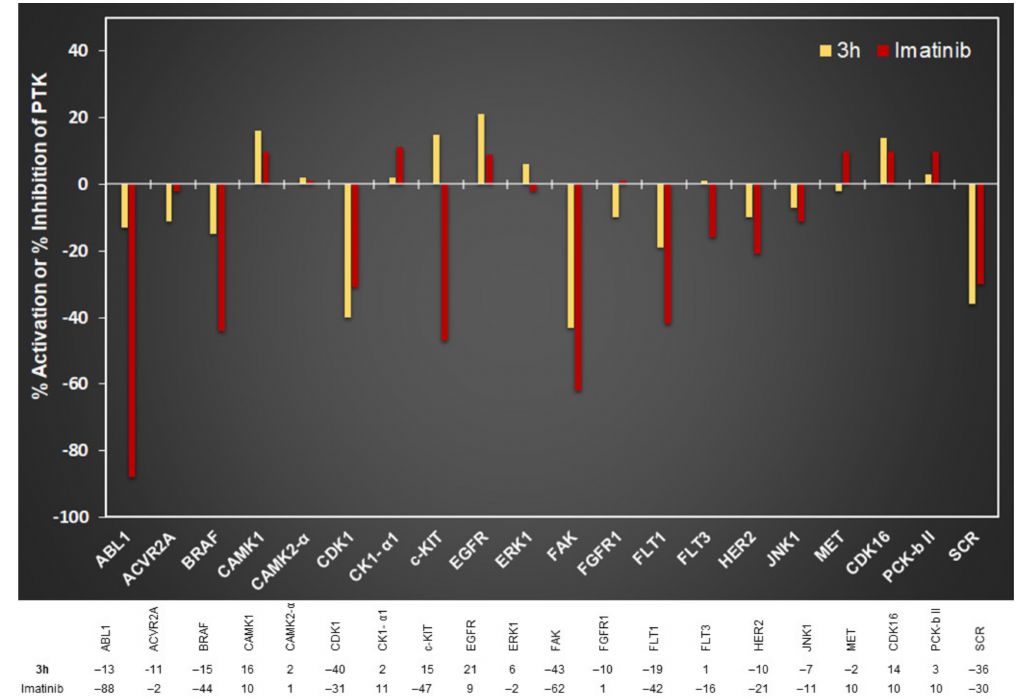
Figure 7. Protein kinase profiling for compound ( 3h ) at 10 µ M concentration against 20 PKs compared to imatinib.